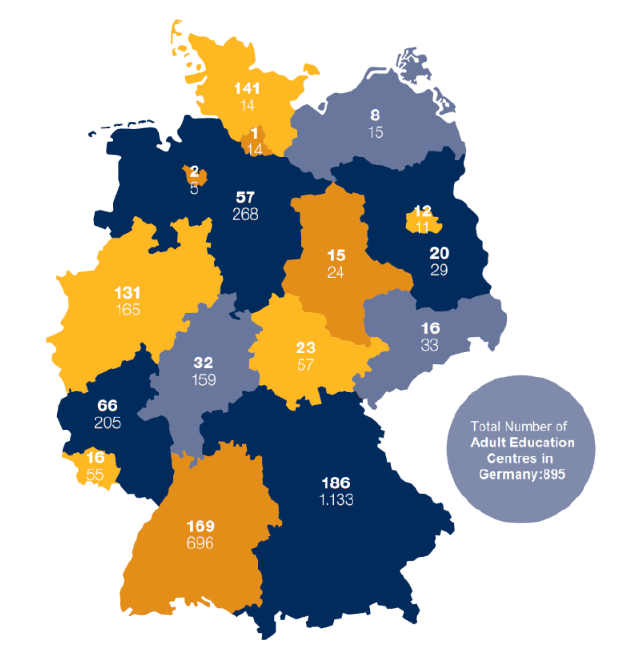
Figure 1. Adult education centres per region in Germany. Also shown are the number of centres and branch offices. (Source: